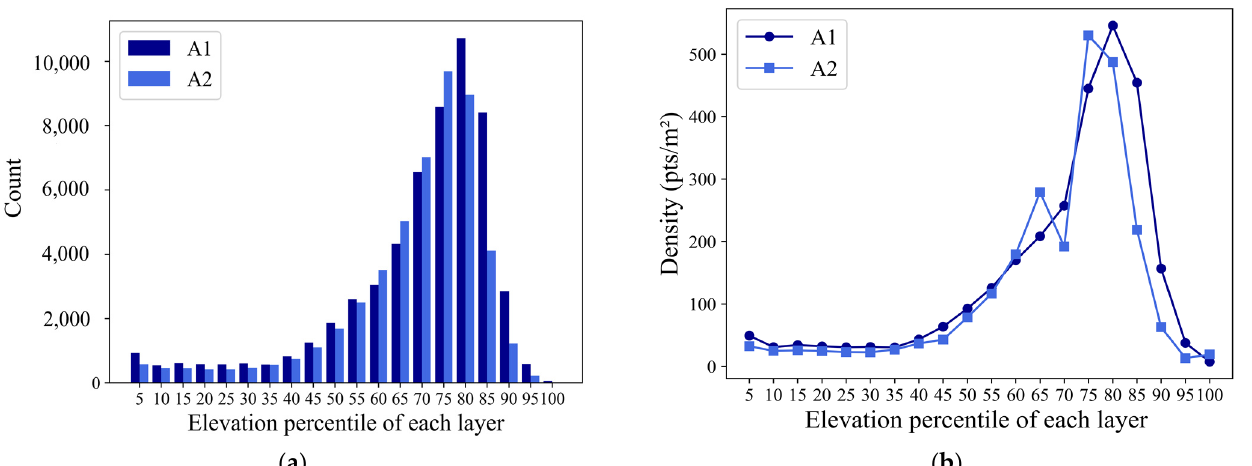
Figure 7. Point cloud distribution at each layer (interval: 5%): ( a ) LiDAR point cloud distribution; ( b ) Point density distribution.